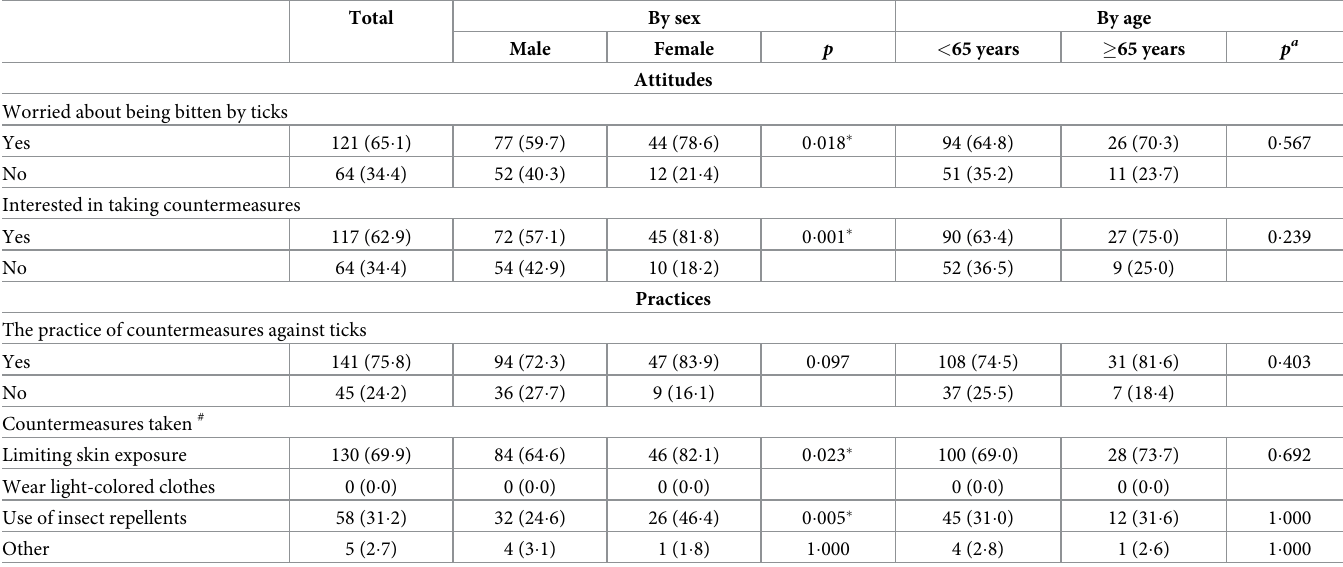
Table 3. Responses to attitudes and practices by sex and